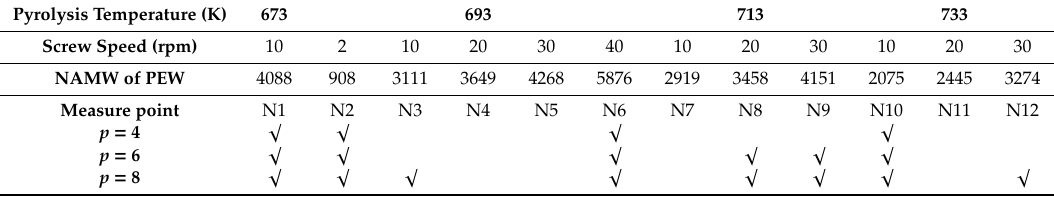
Table 2. The arrangements of measure points under di ff erent values of p